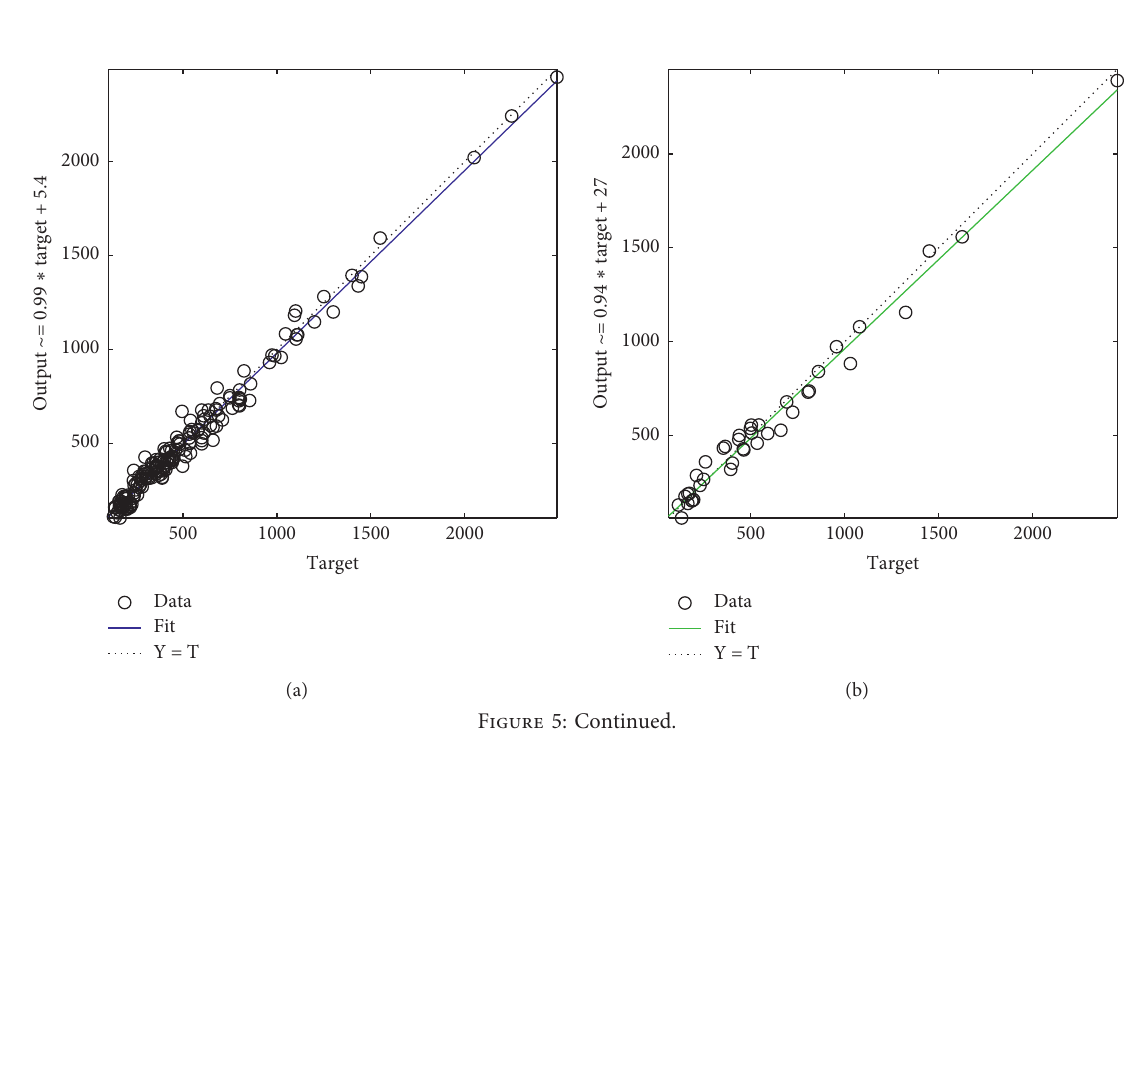
Figure 4: Training process.